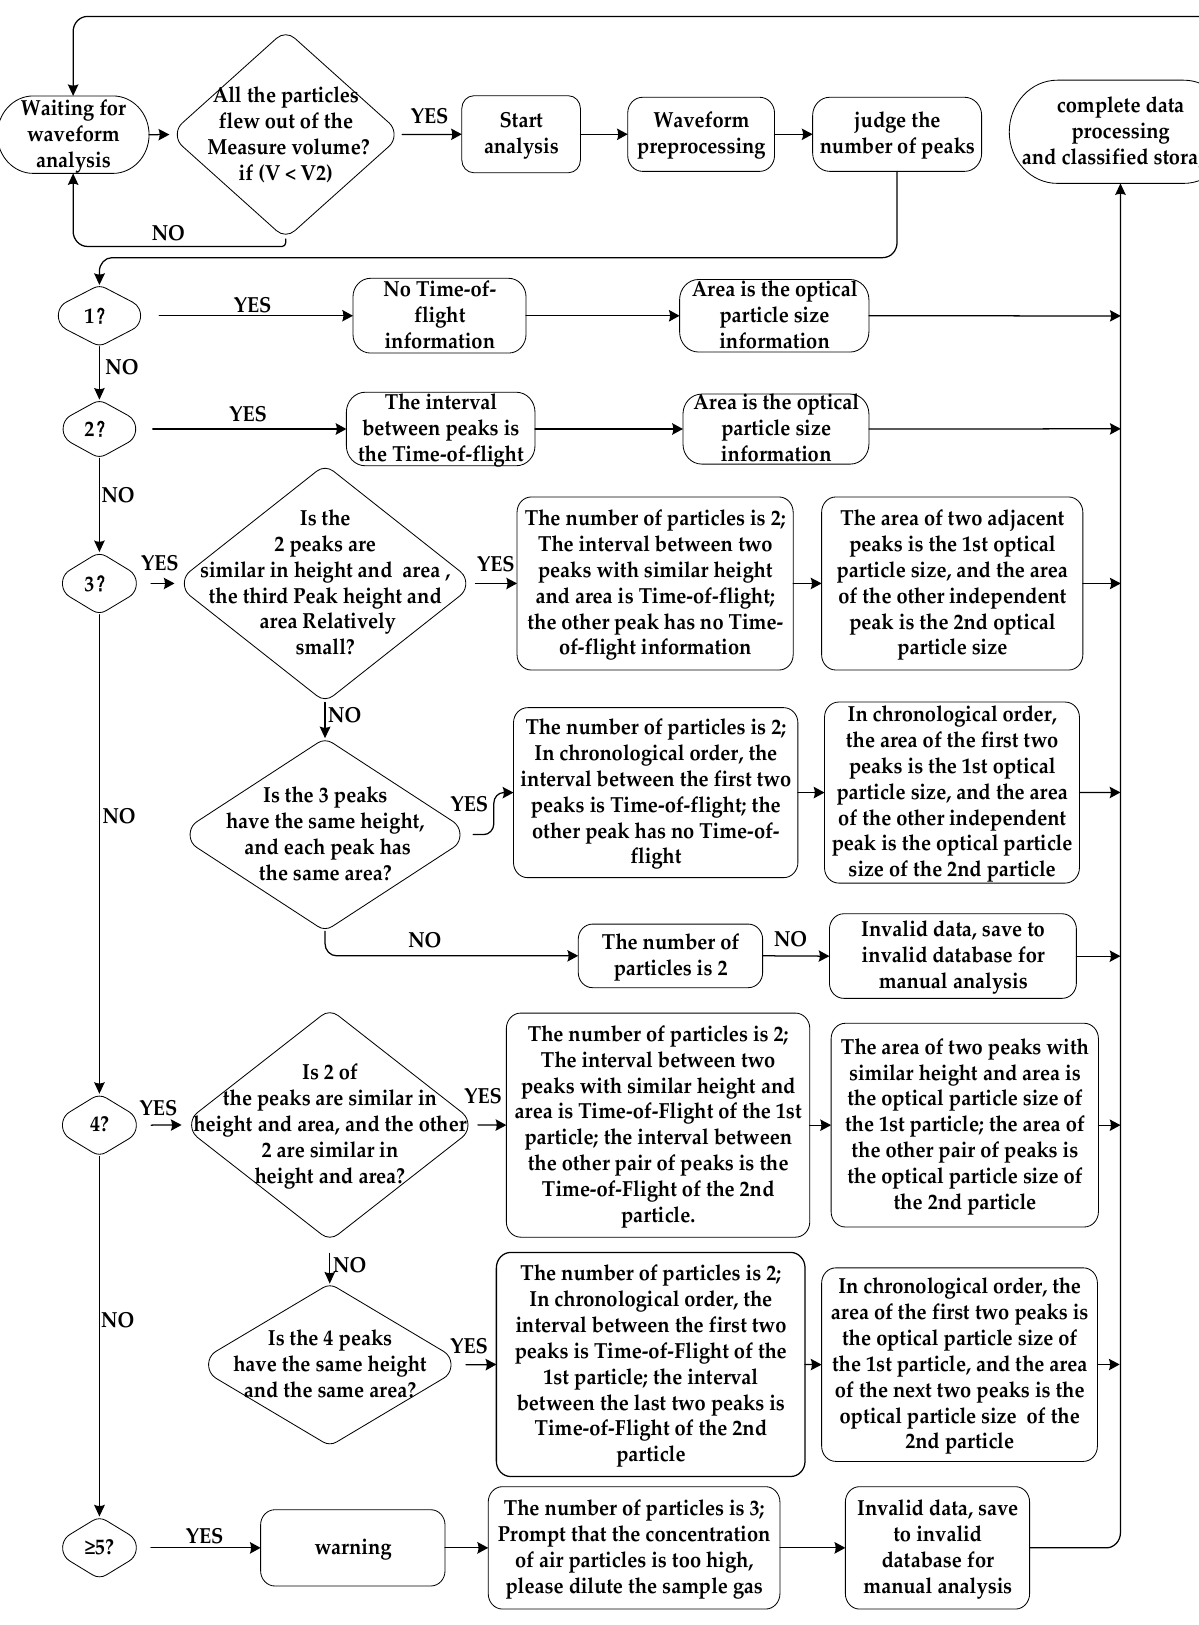
Figure 7. Processing fl ow for anti-overlap algorithm.